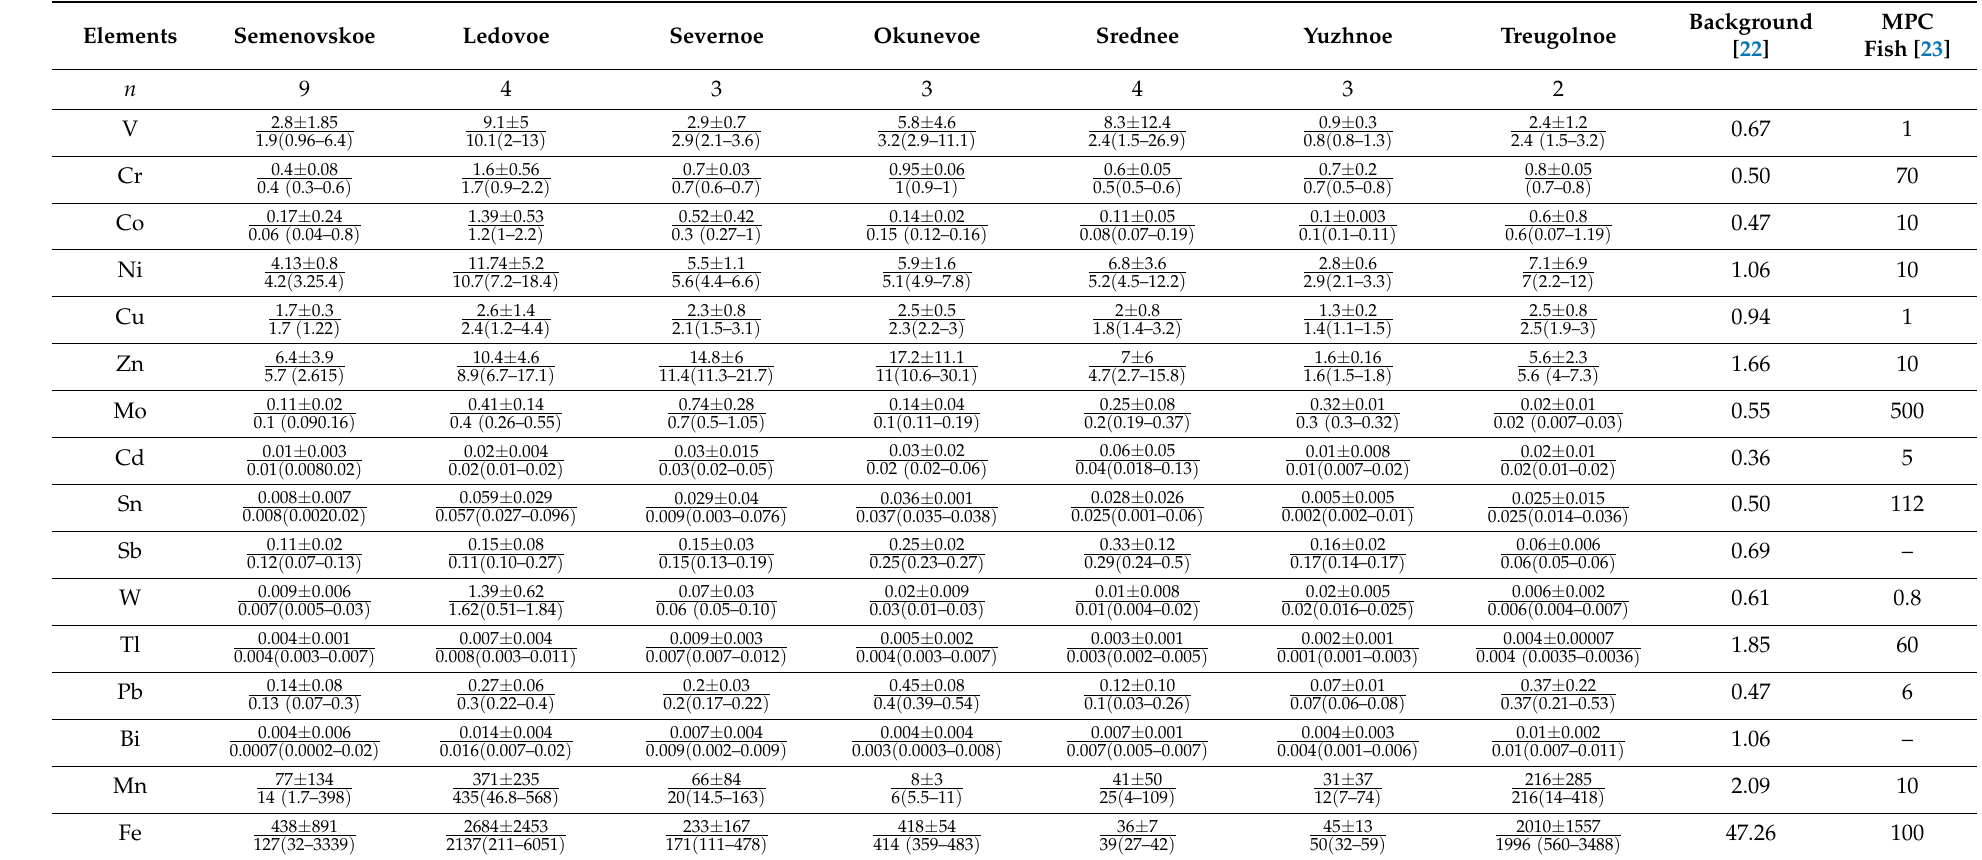
Table 2. The mean concentrations of microelements in the Murmansk lakes, µ